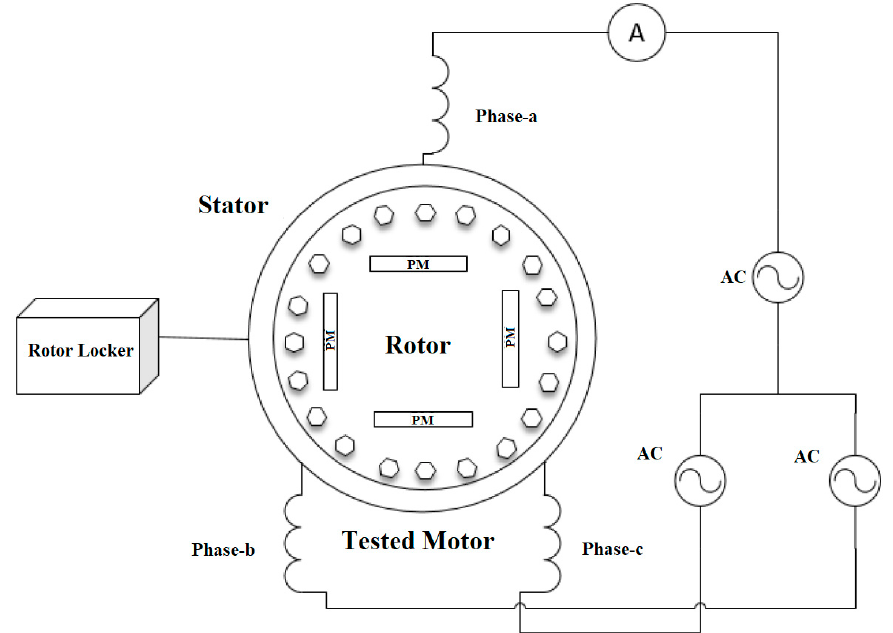
Figure 8. The schematic diagram of locked rotor test.